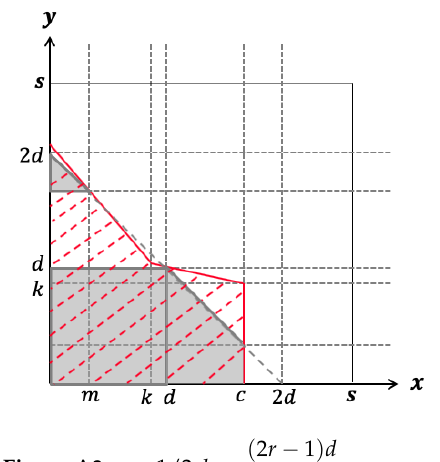
Figure A3. r > 1/2, k >